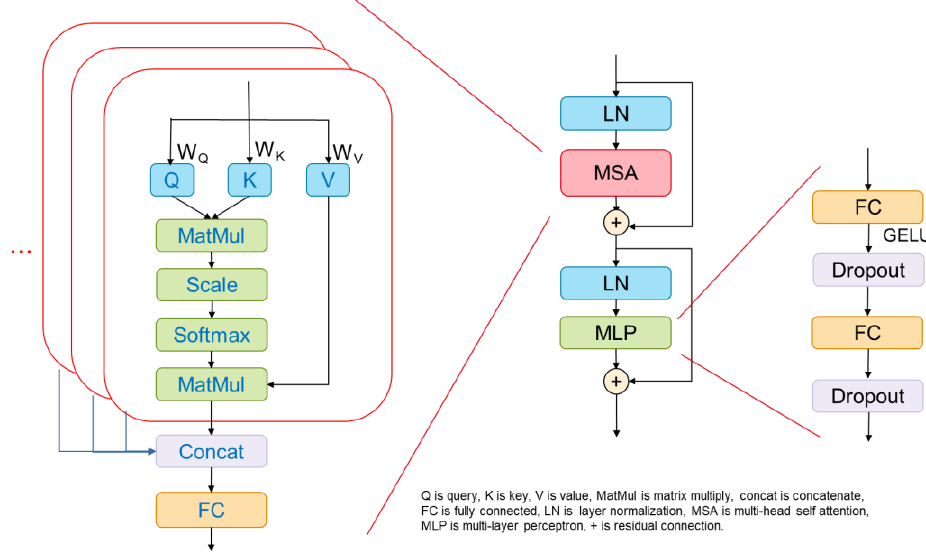
Figure 6. Transformer block.